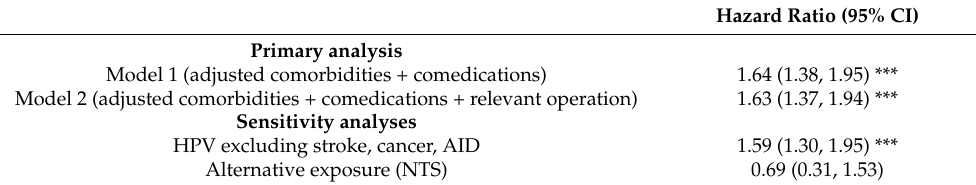
Table 2. Hazard ratios for erectile dysfunction after diagnosis of HPV